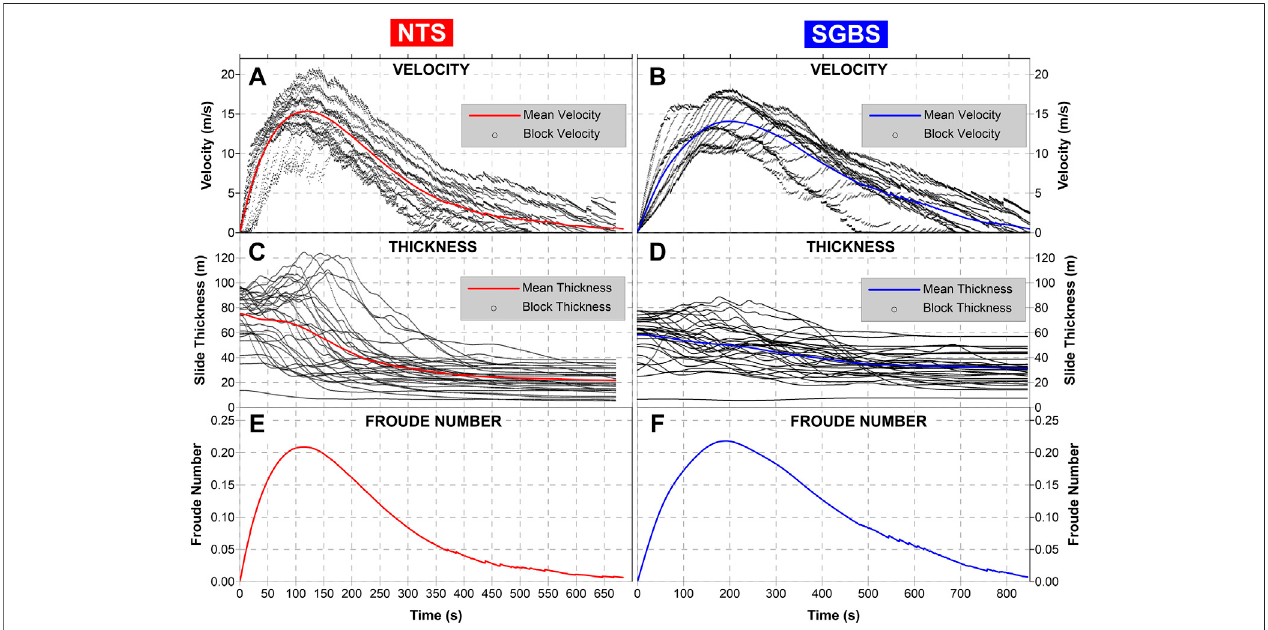
FIGURE5 | Landslide dynamics for NTS (left) and SGBS (right) . (A) Mean velocity (red line) and individual CoM velocity (black dots) vs. time for the NTS scenario. (B) Analogous quantities for the SGBS scenario. (C) Mean thickness (red line) and individual block thickness (black dots) time history for the NTS case. (D) SGBS mean thickness (blue line) and block thickness (black dots). (E) Froude number vs. time for the NTS case. (F) Froude number vs. time for the SGBS scenario.